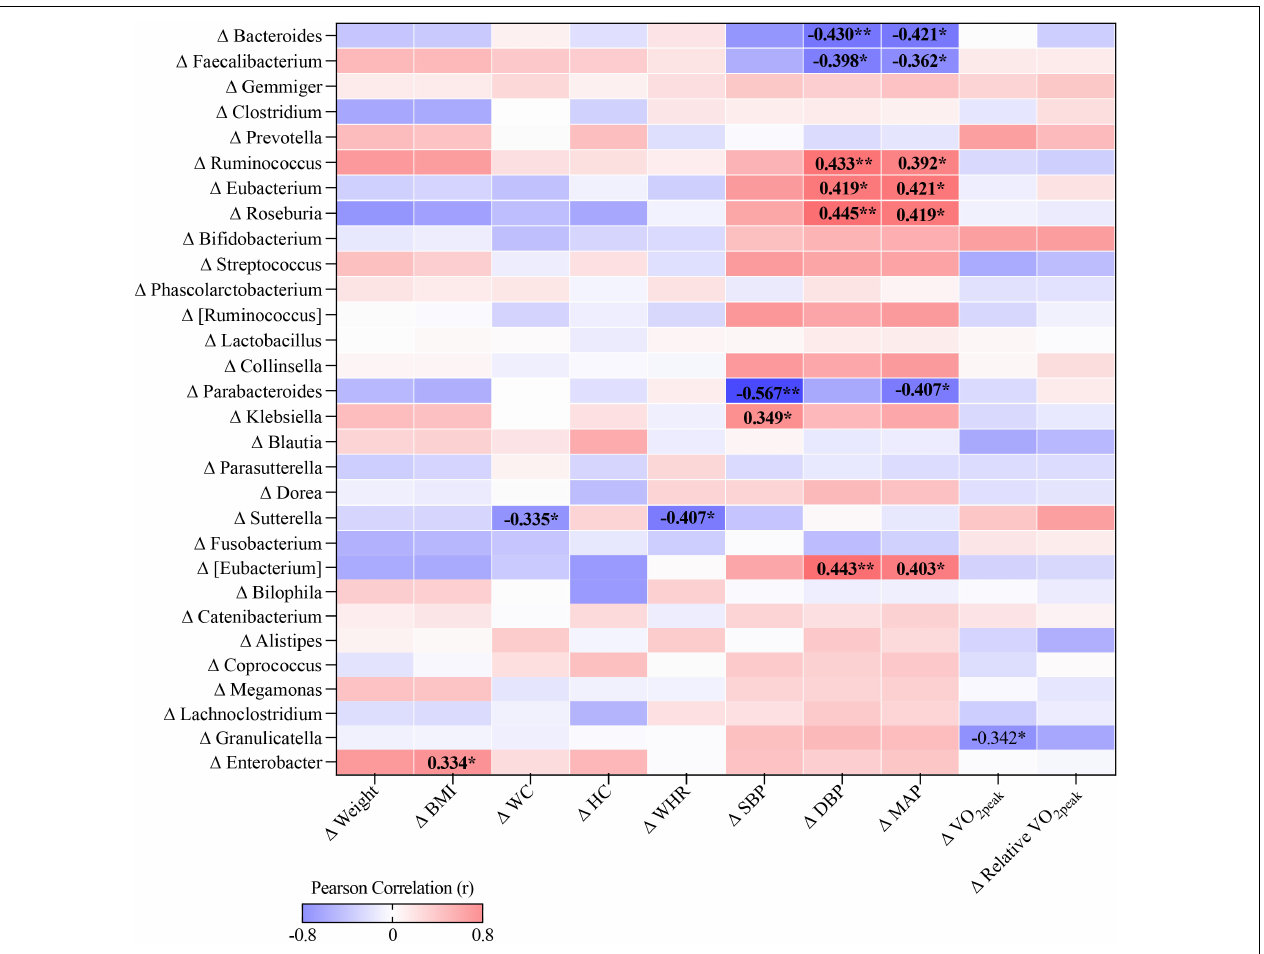
FIGURE 2 | The correlation heat map between changes in cardiometabolic health-related profiles and relative abundance of individual genus, * p < 0.05, ** p <